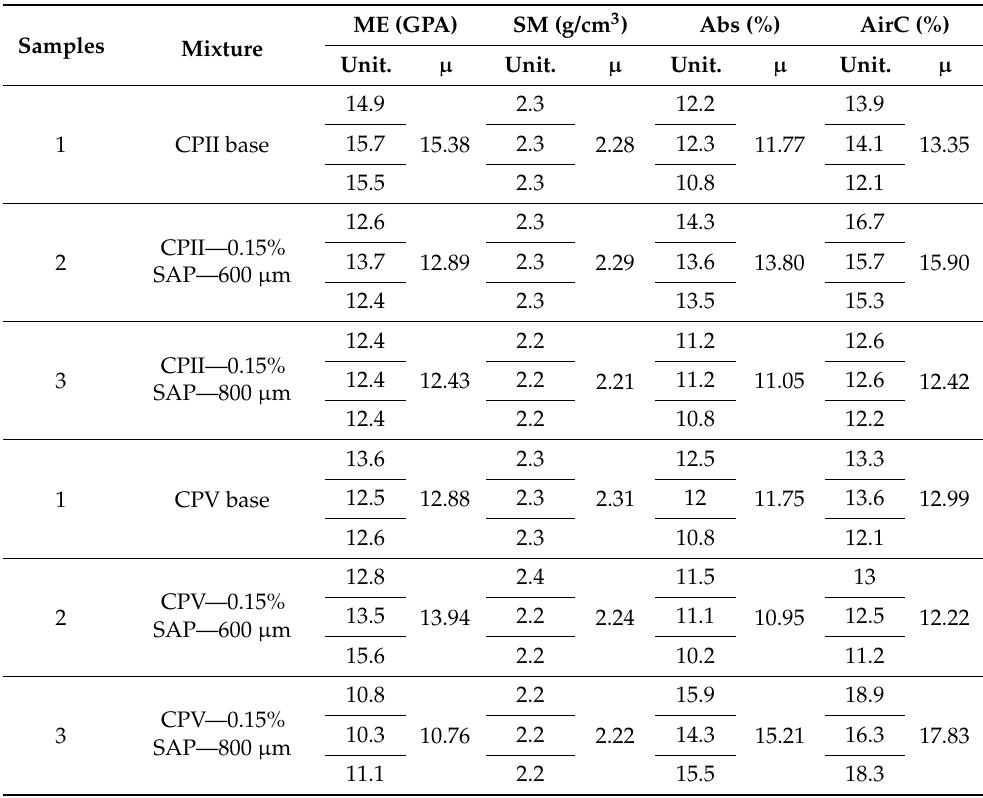
Table 6. Properties of the cement paste at 28 days.